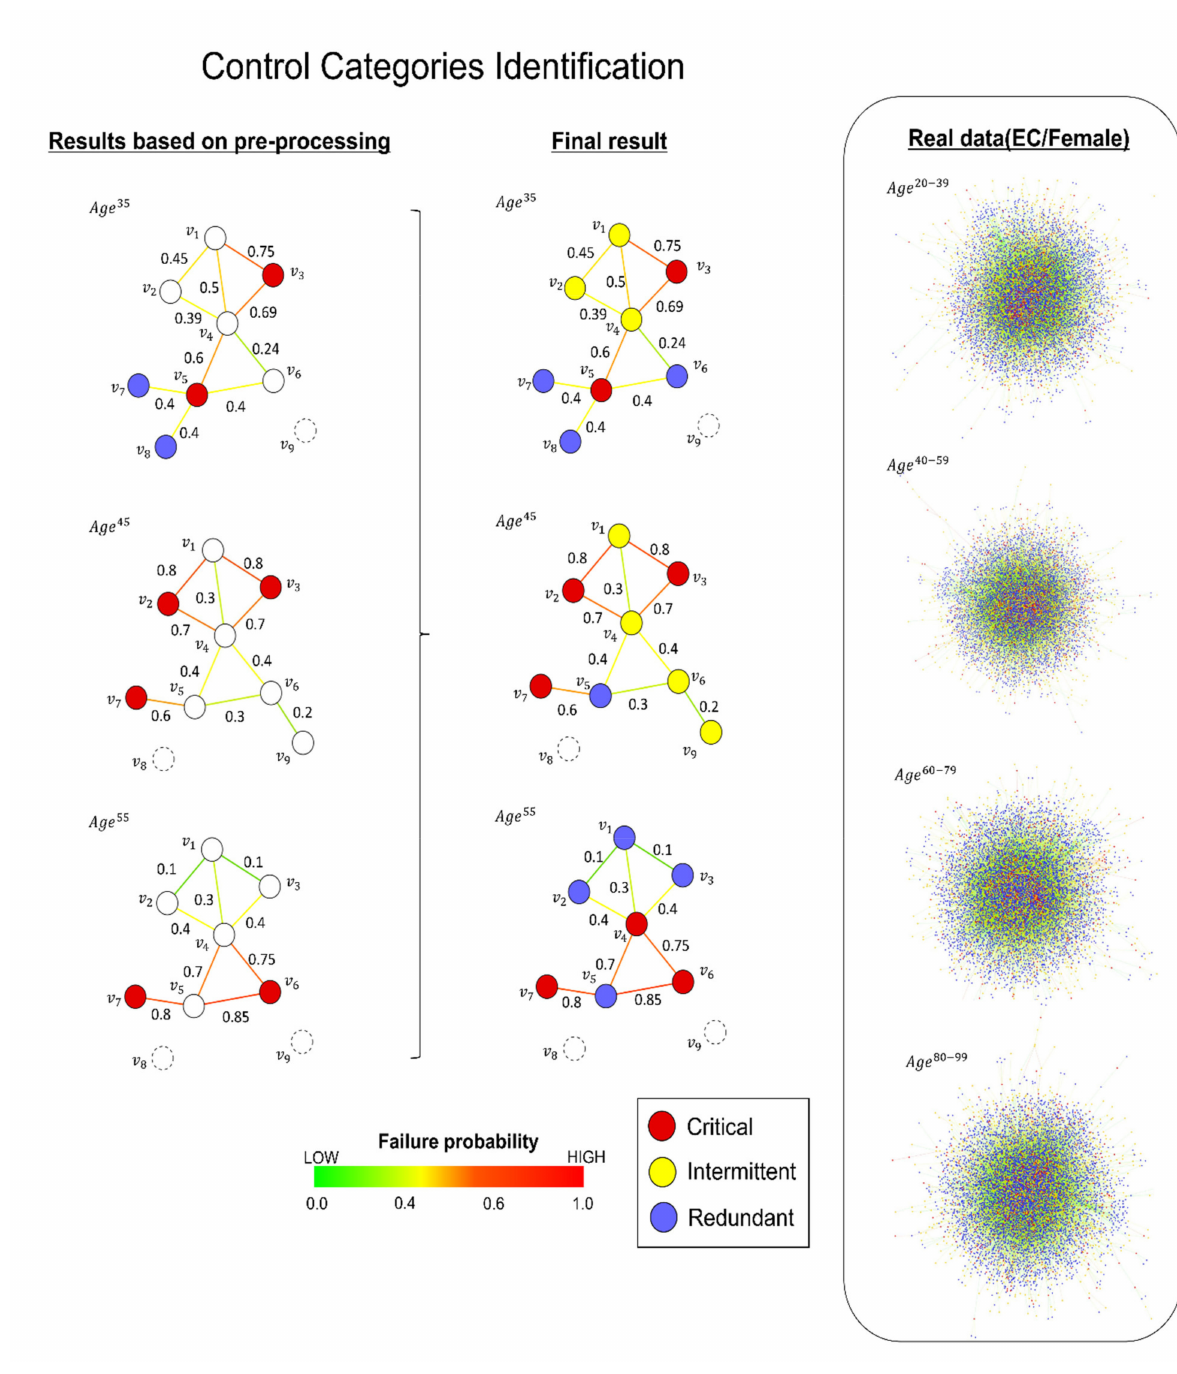
Figure 3. ( Left ) The network results for each control category after applying the preprocessing steps (see Methods section). Note that these results were obtained only by using mathematical propositions 1, 2 and 3, and no ILP computation was needed. ( Right ) The final result of each network after using ILP and the standard control categories algorithm, as shown in Figure 2. Each network edge had a failure probability at a given age that was calculated by subtracting to 1 the interacting strength of each interacting pair (see Equation (3) in